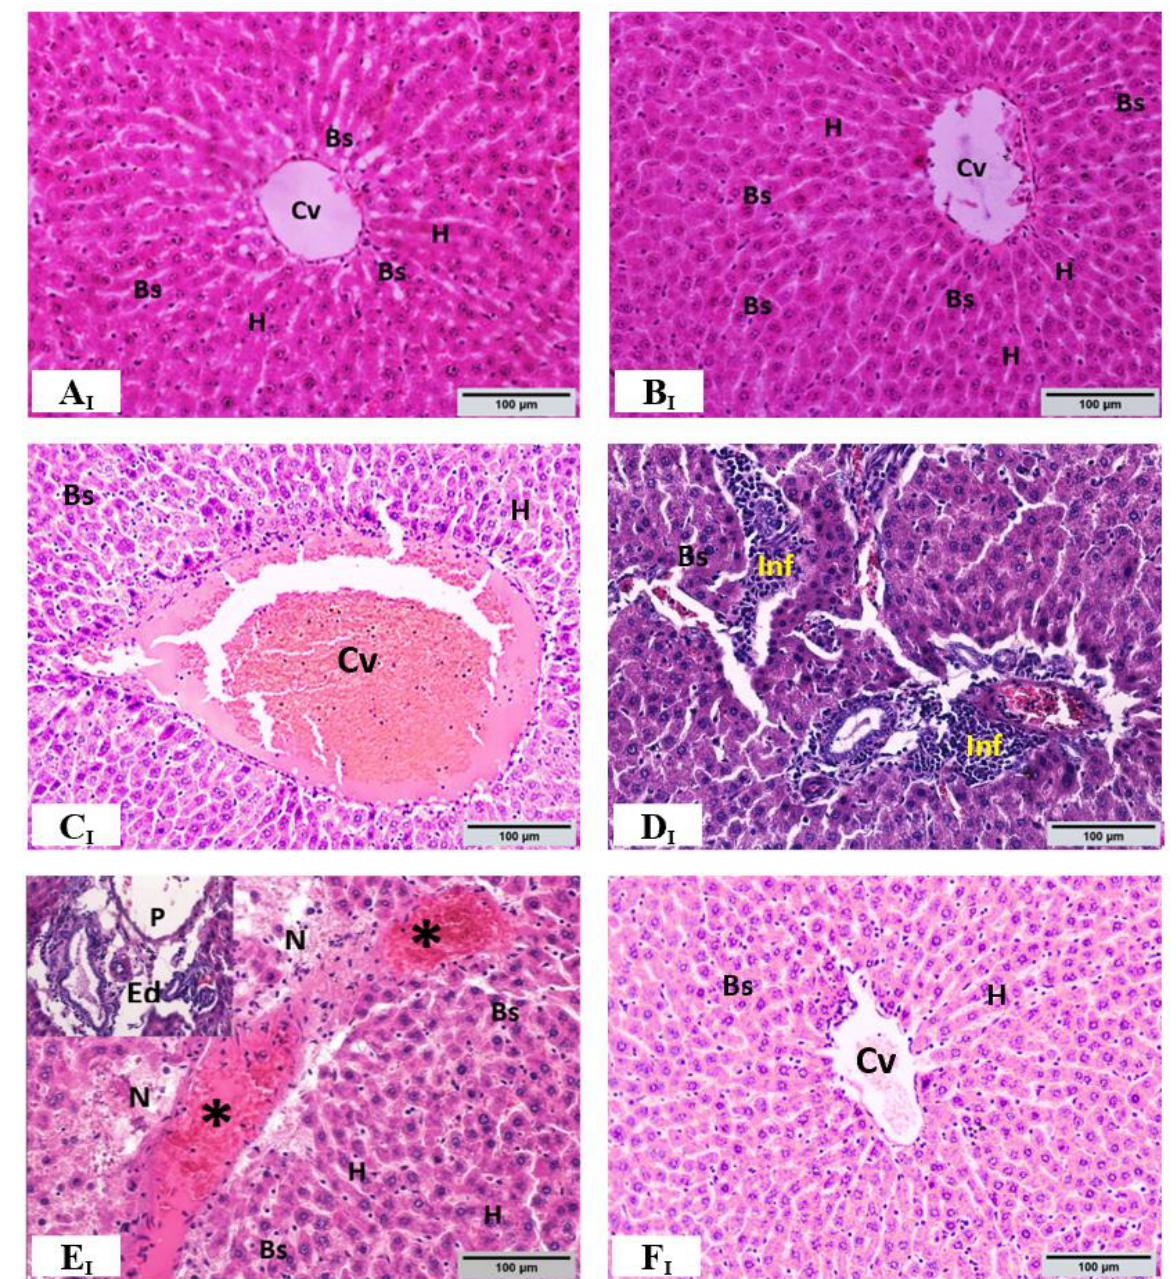
Figure 3. I. Representative photomicrographs for histopathological changes in hepatic tissues after 30 days of treatment. ( A I ): Liver of control rats showing normal hepatic architecture with typical histological structure of the hepatic lobule with normal central vein (Cv). Normal hepatic strands (H) radiate from the central vein towards the periphery of the hepatic lobule and are separated by sinusoidal spaces (Bs); and absent of any abnormal changes. ( B I ): The liver of rats from C. myrrha extract group showing no significant alterations in lobular structure. ( C I – E I ): Livers of rats from ethanol-treated rats show dilation of congested central vein, lymphocyte infiltration (Inf), sinusoid hemorrhage (*), necrosis (N), and “edematous (Ed) area around the blood vessels at the portal space (P) inset at the upper left corner of the figures ( E I )”. ( F I ): Group treated with C. myrrha extract + ethanol showing improved histopathological alterations in hepatic tissues compared with ethanol-treated group. Hematoxylin and eosin (H & E stain; 200×, scale bar 100 µm).